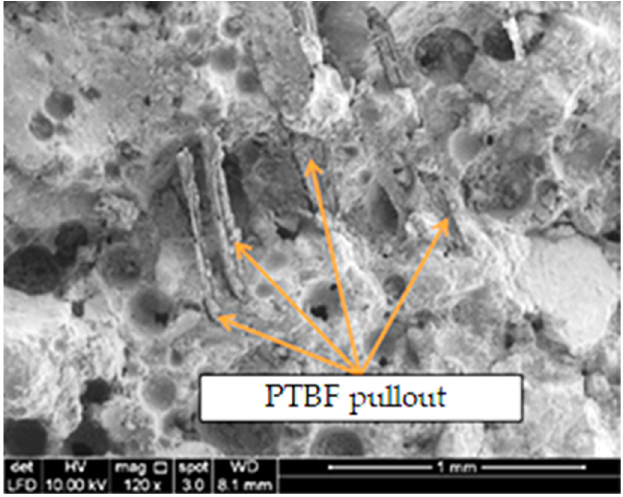
Figure 25. Sign of PTBF pullout after flexural